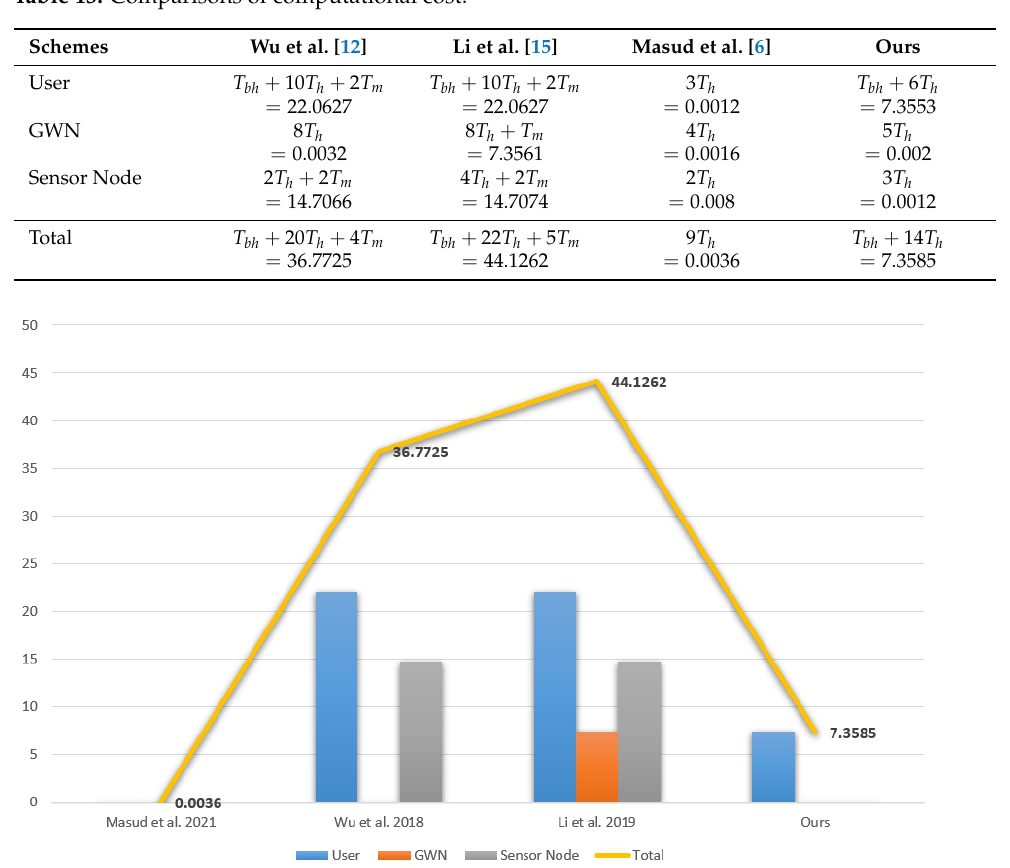
Figure 2. Graph comparisons of computational cost